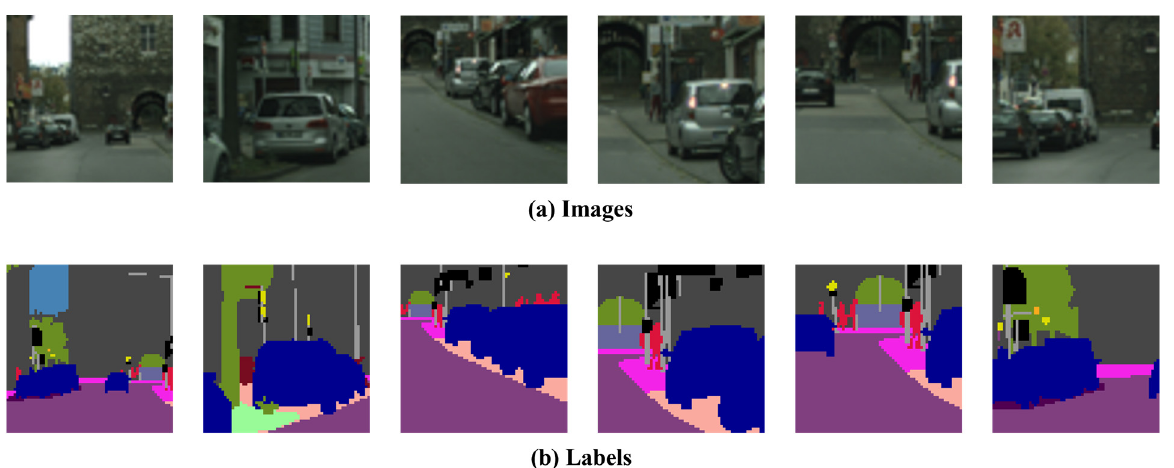
Figure 2. Example of data pre-processing.